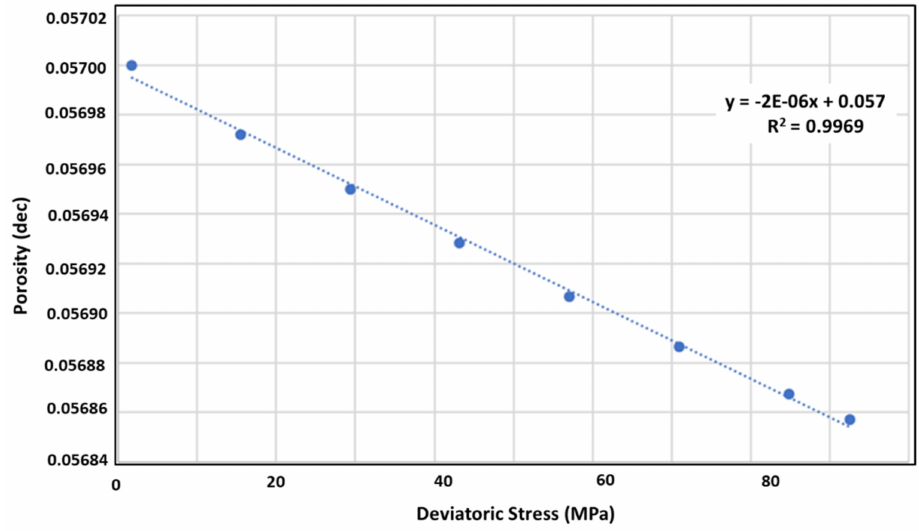
Figure 17. Change in porosity with deviatoric stress for the dry sample measurement at confining stress of 20.68 MPa of our Permian basin rock sample.